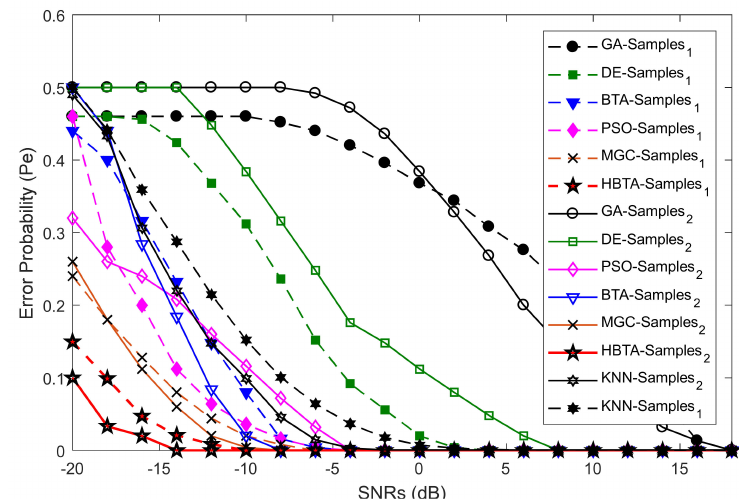
Figure 20. Error probability vs. SNRs in the presence of AN-ANC users with sensing samples 1 (280) and samples 2 (305).